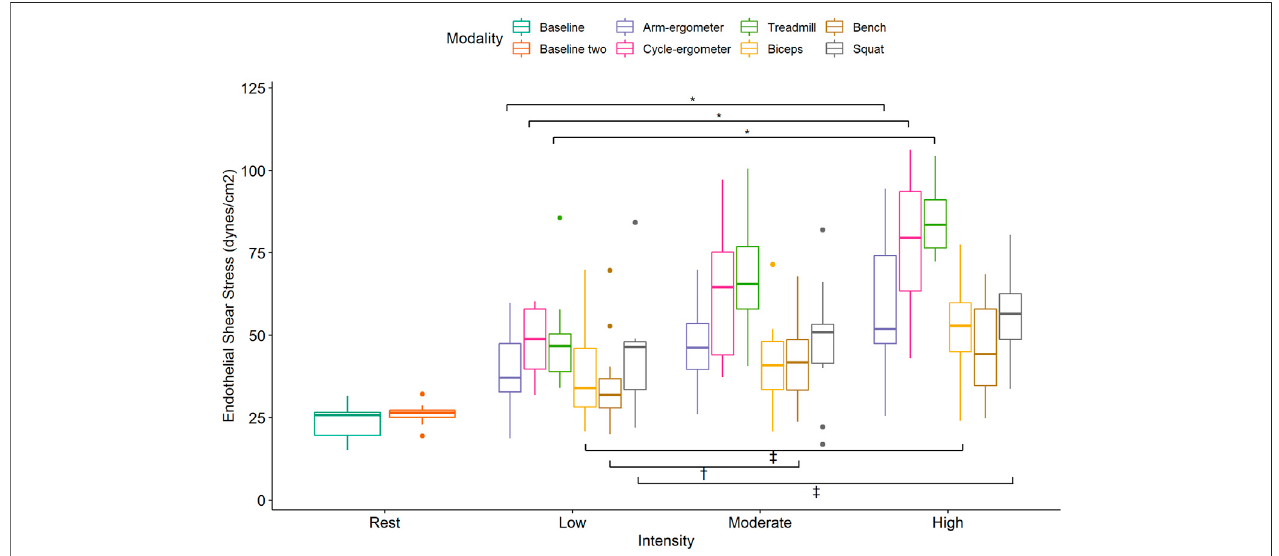
FIGURE 4 | Boxplot of Endothelial Shear Stress (ESS) by exercise modality and intensity with comparisons within modalities at each intensity. *, p < 0.05 low vs. moderate, low vs. high, and moderate vs. high; † , p < 0.05 low vs. moderate Bench press; ‡ , p < 0.05 low vs. high and moderate vs. high; † , p < 0.05 low vs. moderate Biceps and Squat.